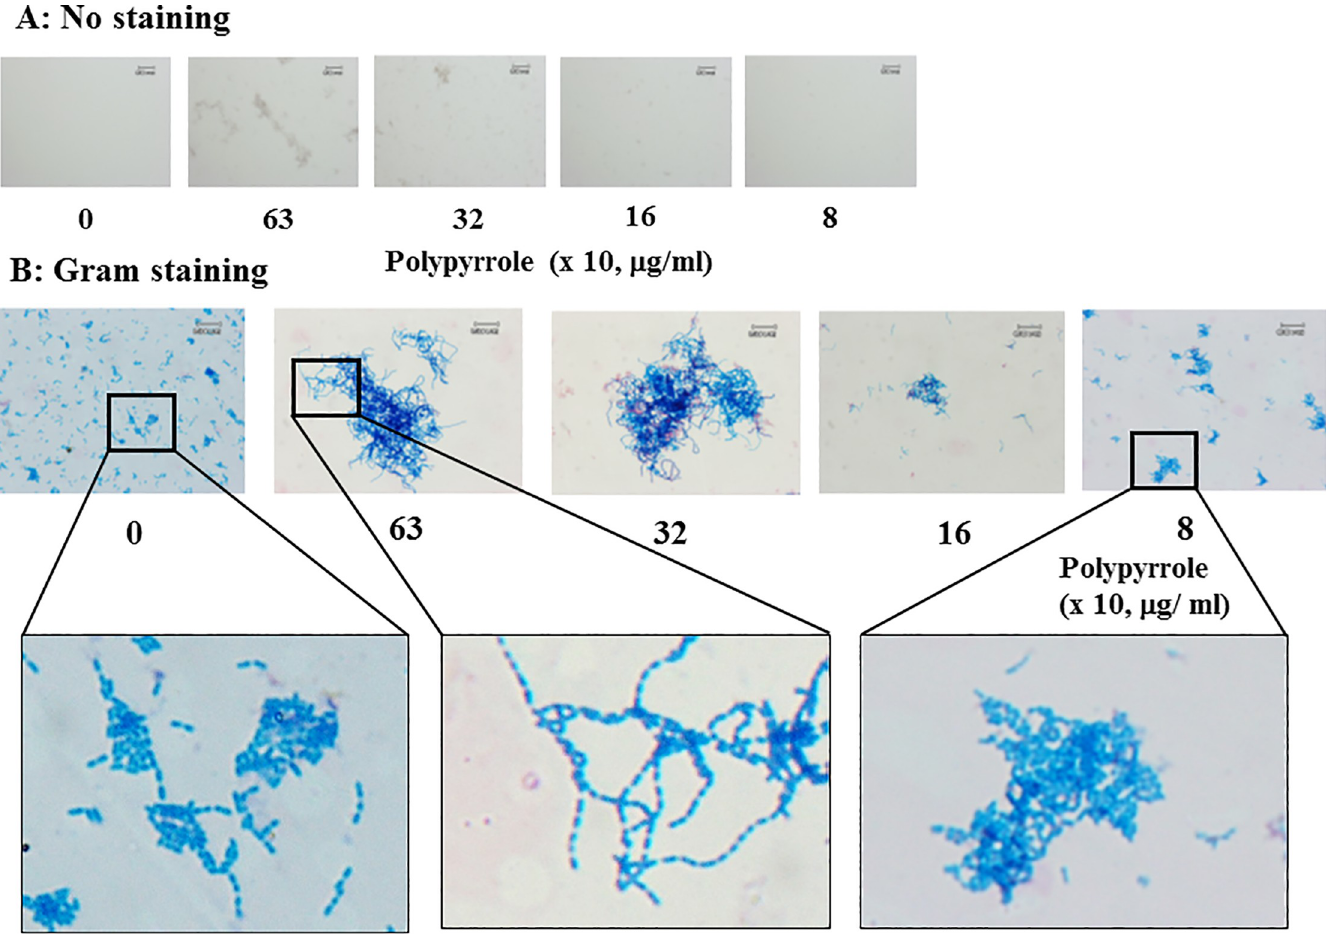
Fig 4. Microscopic observation of biofilms treated with high concentrations of polypyrrole. GtfBC mutant was incubated with 0 (control), 8, 16, 32 and 63 x 10 μ g/ ml polypyrrole and stained without (A) or with (B) a Gram staining kit. The aggregates were observed by microscopy. Squares were presented as an enlarged view. Representative data from more than three independent experiments were presented in the images.